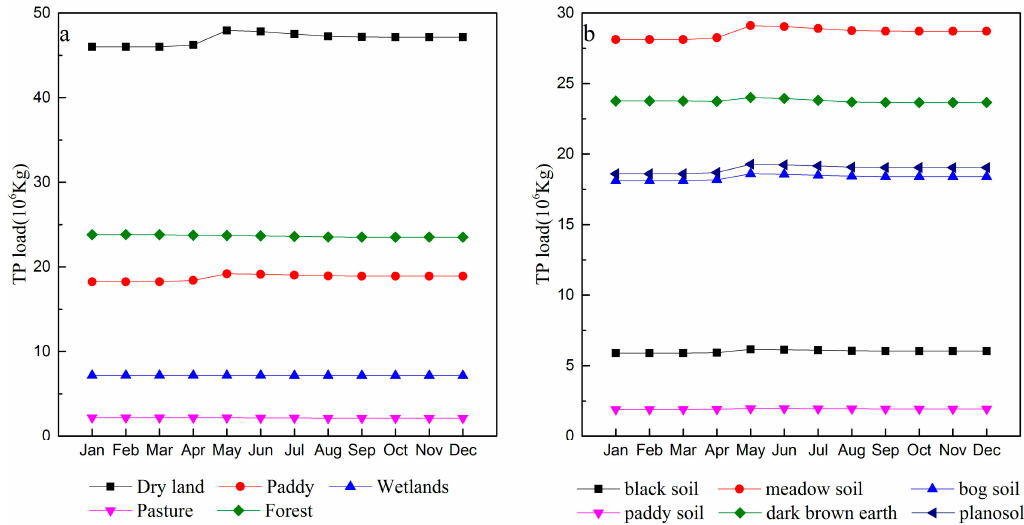
Figure 12. Monthly total phosphorus (TP) load from each: land use type ( a ); and soil type ( b ).